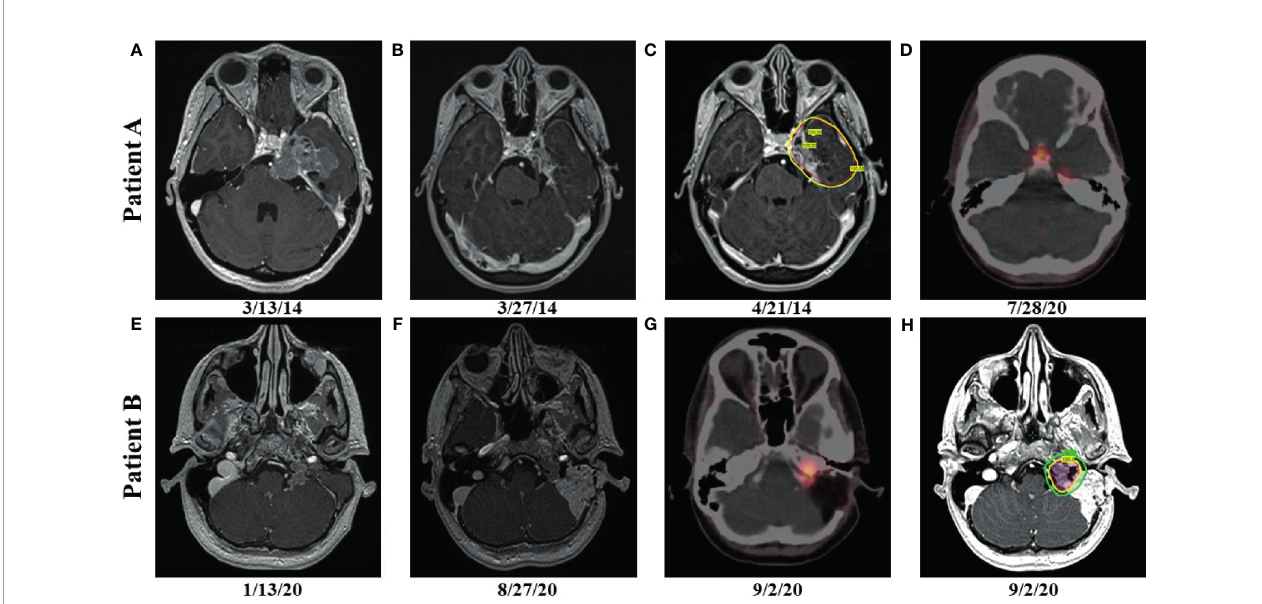
FIGURE 1 | Patient A: preoperative, axial T1 postcontrast weighted magnetic resonance (MRI) imaging showing enhancing disease (A) ; postoperative, axial T1 postcontrast weighted MRI imaging showing enhancing, residual disease (B) ; radiation therapy (RT) planning using volumetric arc therapy (VMAT) resulted in excellent coverage of the planning target volume (PTV) (red) by the 100% isodose line (yellow) corresponding to 5940 cGy (C) ; follow up gallium-68 dotatate positron emission tomography (PET) after more than 6 years showing hypermetabolic, recurrent disease in the left tentorial lea fl et and physiologic uptake in the pituitary (D) ; Patient B: preoperative, axial T1 postcontrast weighted MRI imaging showing enhancing disease (E) ; postoperative, axial T1 postcontrast weighted MRI imaging showing enhancing, residual disease (F) ; postoperative PET showing hypermetabolic, residual disease (G) ; RT planning using VMAT resulted in excellent coverage of the 6000 cGy (red) and 5400 cGy (blue) PTVs by the 100% (yellow) and 90% (green) isodose lines, respectively (H)